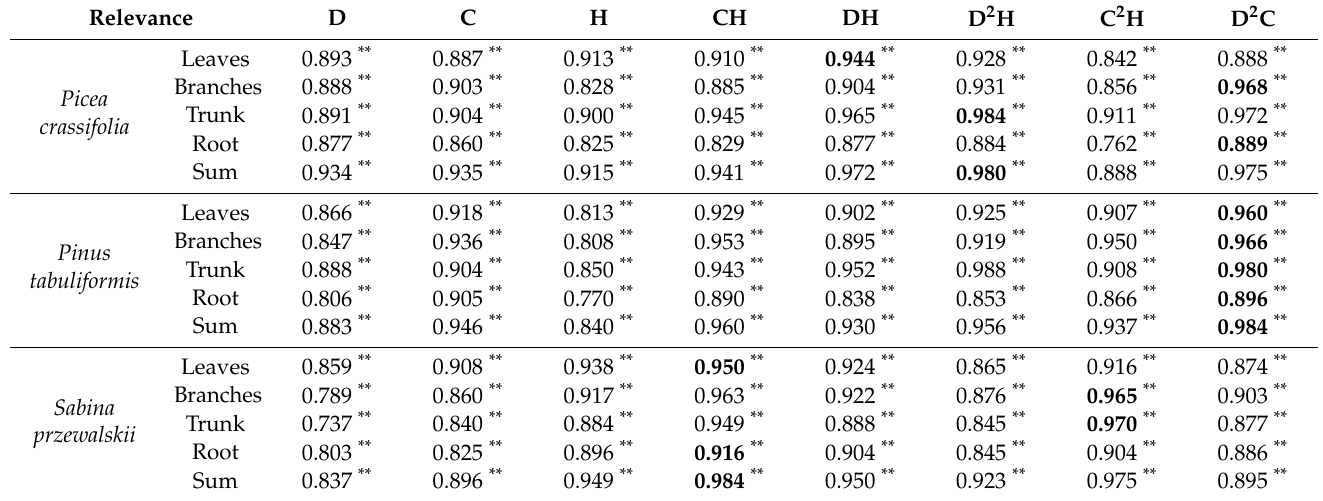
Table 2. Correlation analysis between modeling variables and the biomass of each